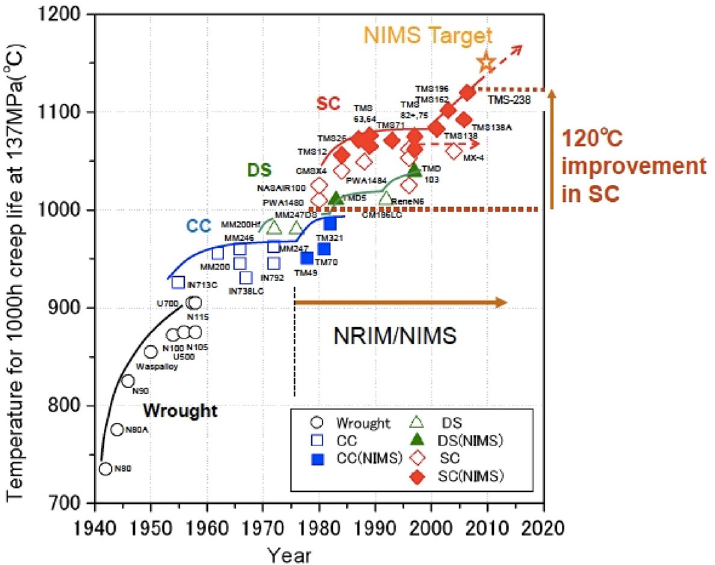
Figure 1. The development in creep rupture temperature capability of Ni-base superalloys under 1100 ℃ —137 MPa 3 .